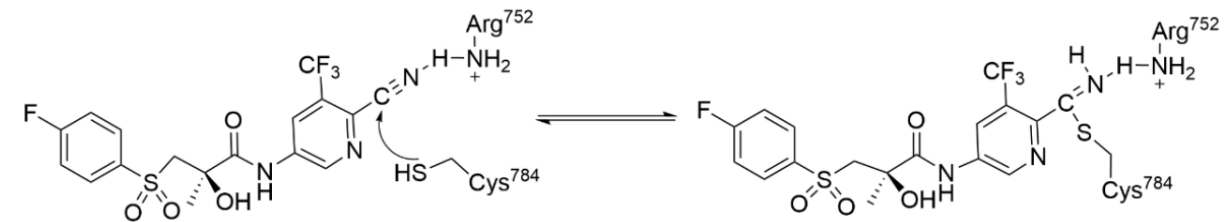
Figure 15. The reaction mechanism of 5N ‐ bicalutamide with Cys784.